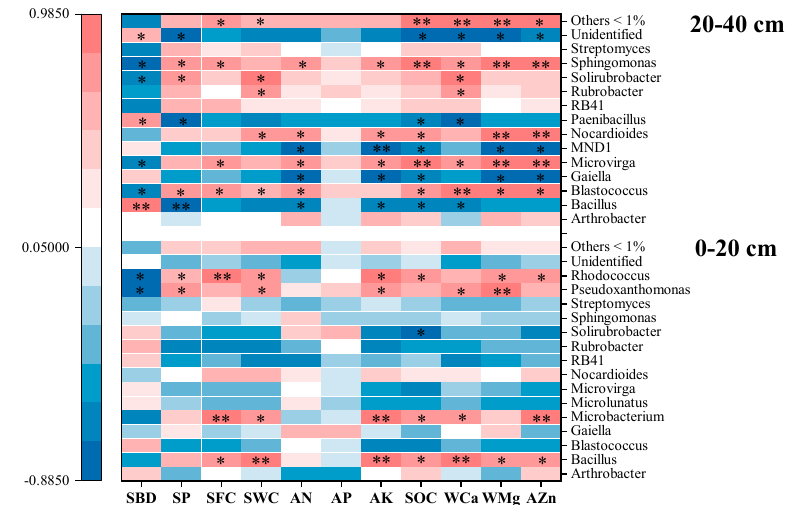
Figure 4. Analysis of soil bacterial community composition as affected by soil property. Spearman correlation analysis between soil characteristics and bacterial abundance on genus level. * indicates significant correlation ( p < 0.05), while ** indicates extremely significant correlation ( p < 0.01).